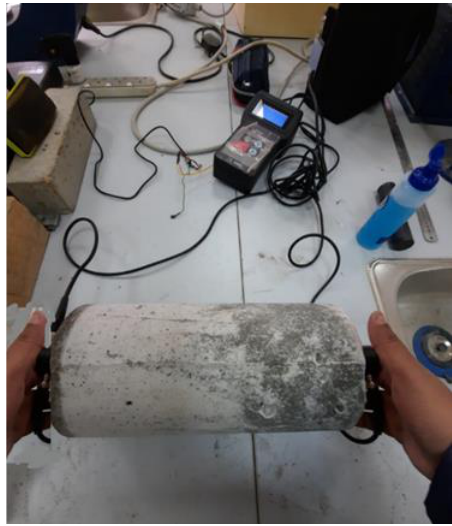
Figure 13. UPV of the concrete